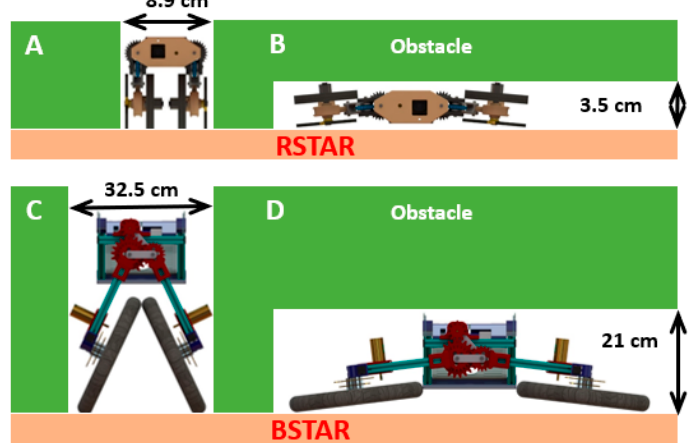
Figure 11. The width and height of obstacles that the RSTAR and BSTAR can pass between or underneath. ( A ) The RSTAR passing between obstacles. ( B ) The RSTAR squeezing underneath and obstacle. ( C ) The BSTAR passing between obstacles. ( D ) The BSTAR squeezing underneath an obstacle.